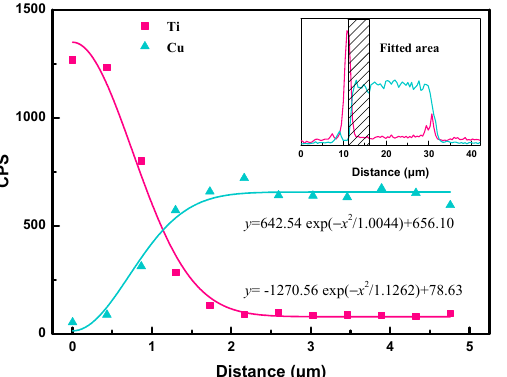
Figure 9. Data points of Ti and Cu from line scanning EDS analysis and their fitted curves. Figure 10 shows the morphology and EDS result of the crater left by the TC particle. The yellow dashed line was the outline of the original alloy particle, and the blue-grey area referred to the interface between the original alloy particle and the matrix. From the EDS result for point B, the elemental mass ratio of Ti to Cu (W Ti/Cu % = 22.64%) was high- er than that of the un-sintered alloy particle (W Ti/Cu % = 15.29%, in Figure 1). In summary, the diffusion coefficient of Ti and Cu were 7.82 × 10 –11 and 6.98 × 10 –11 cm 2 /s (950 °C), re- spectively. Although the actual starting content of Ti was lower than that of Cu, the dif- fusion of Ti is still greater than that of Cu during interfacial diffusion, which was con- sistent with the calculation of the diffusion coefficient, which indicated that Ti diffused better than Cu in the matrix.